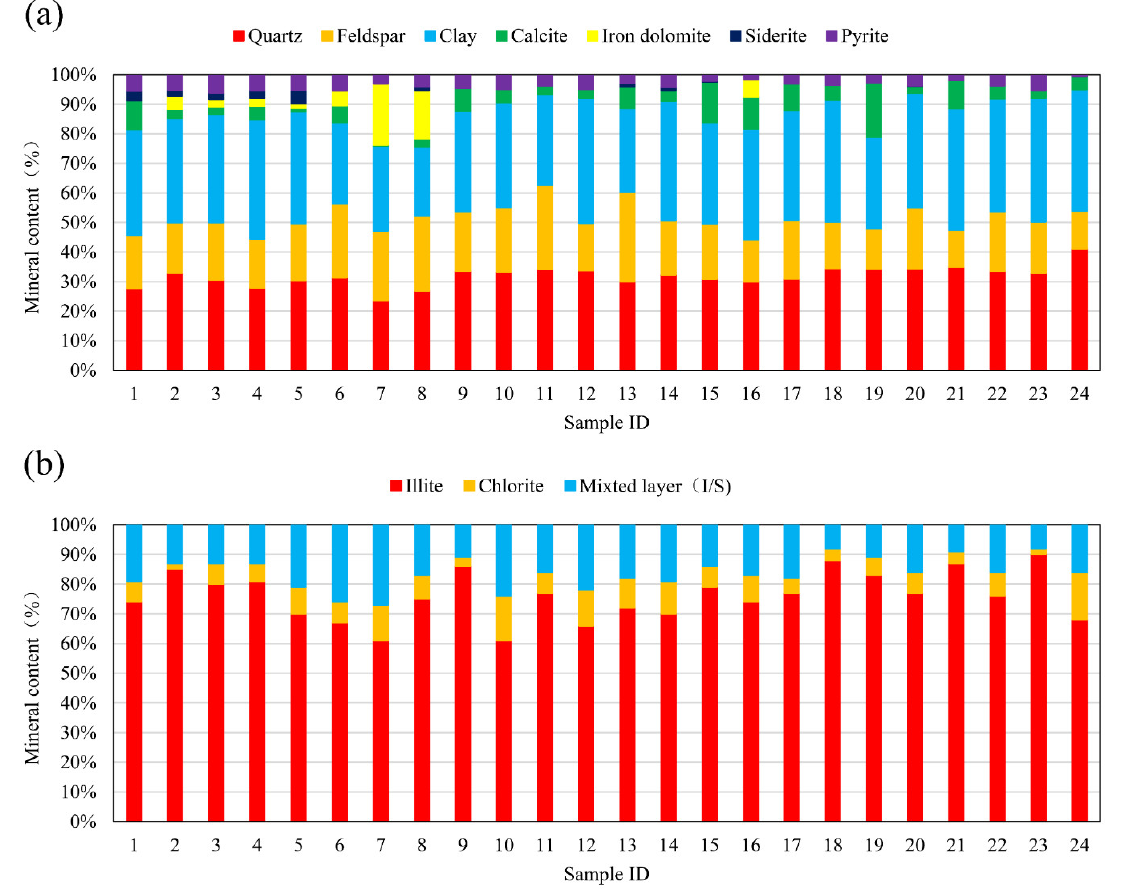
Figure 2. Histograms of the mineral composition of Qingshankou lacustrine shale samples. ( a ) Whole rock mineral compositions; ( b ) Clay mineral compositions.